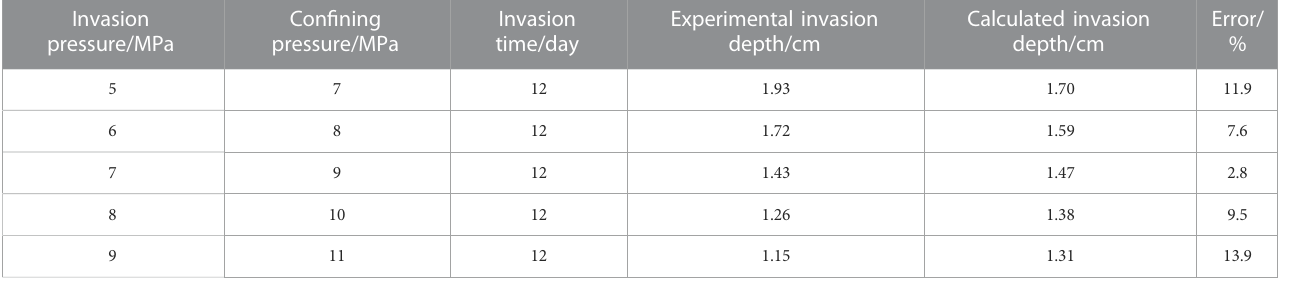
TABLE 4 Calculated and experimental values of invasion depth under different invasion pressures and con fi ning pressures.